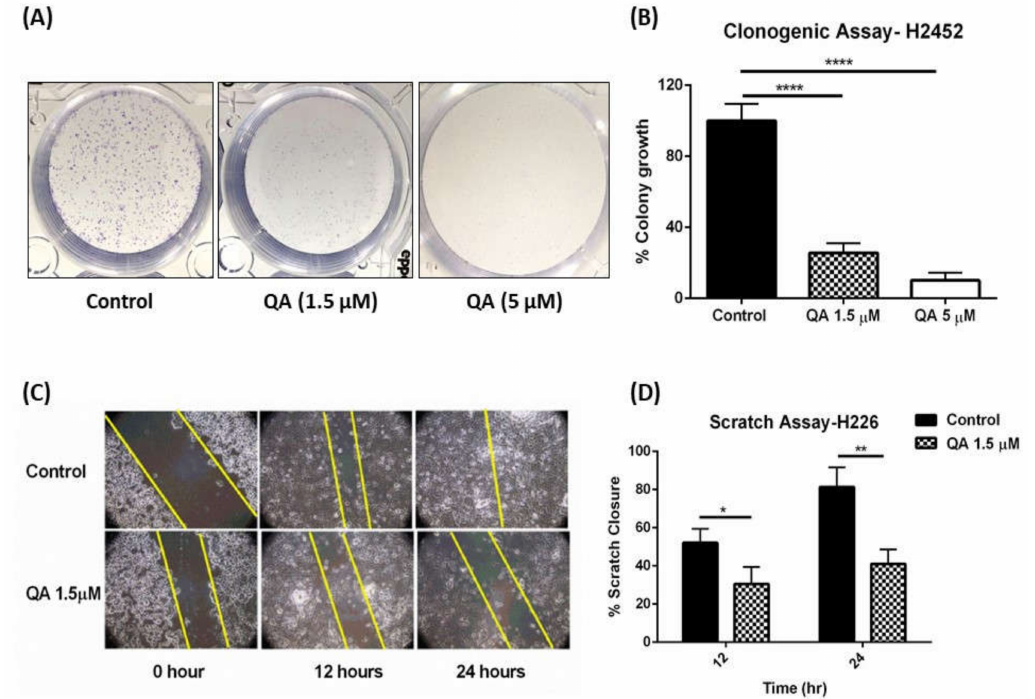
Figure 2. Evaluation of QA e ffi cacy on colony formation and cellular migration in Malignant Pleural Mesothelioma (MPM) cells. ( A ) Clonogenic assay performed on H2452 cells with 500 cells / well with two concentrations of QA (1.5- and 5- µ M). A concentration dependent inhibition of colony formation can be seen as 5 µ M QA shows negligible formation of H2452 colonies. ( B ) Quantification of % colony growth per treatment relative to control. Significant di ff erence between colony growth is seen between control group of cells and QA-treated cells. ( C ) Representation of scratch assay done on a confluent layer of H226 cells. Scratch is represented as yellow lines draw across the image. Scratch closure is more predominant in untreated cells in comparison to QA-treated cells. ( D ) Percent of scratch closure for control group of cells and QA (1.5 µ M)-treated cells. A significant di ff erence can be seen in % scratch closure at both time points between QA-treated and untreated cells. Data represent mean ± SD ( n = 3), * p < 0.05, ** p < 0.01, **** p < 0.0001 compared between treatments and control groups, as